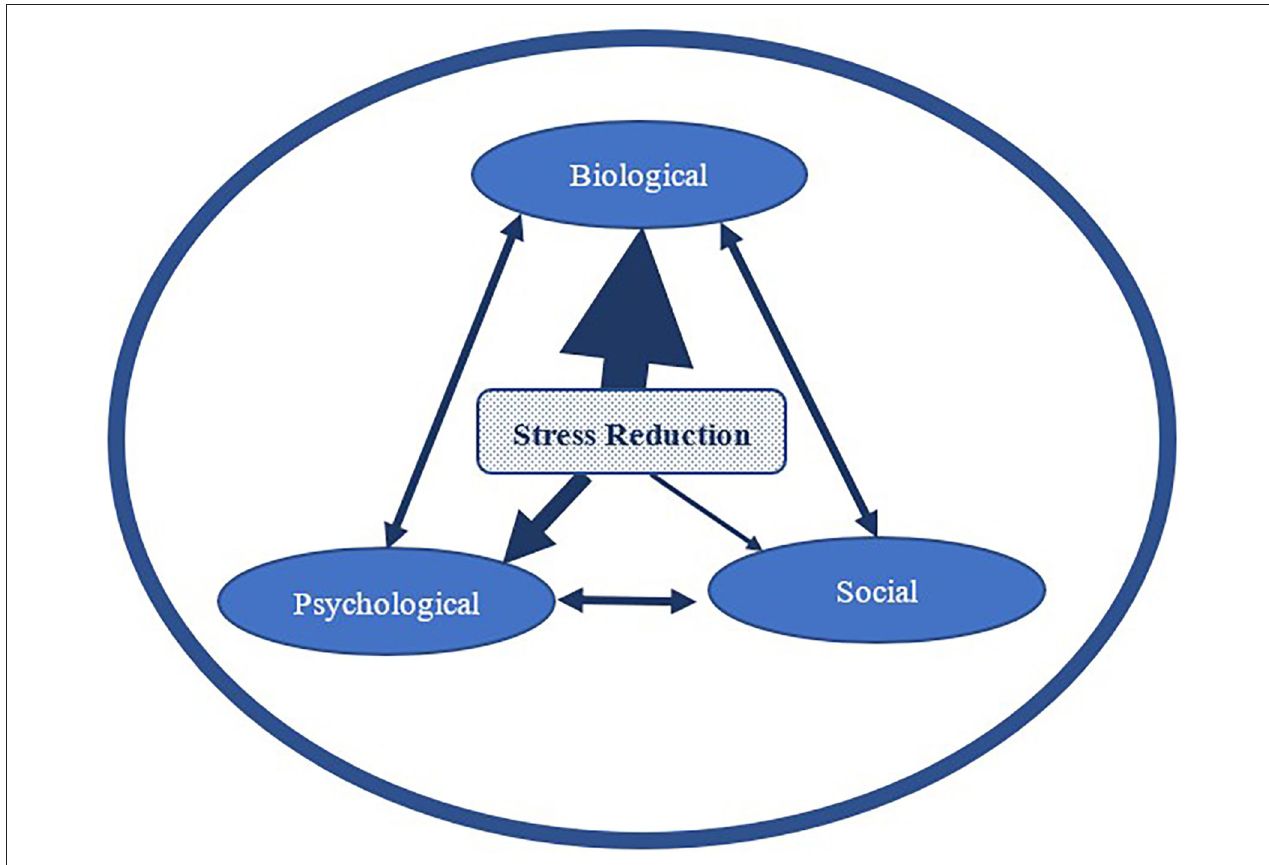
FIGURE 2 | An example of the potential for differential impact (represented by the different arrow thickness) of one mechanism of action (stress reduction) on the three realms of influence of overall health and well-being (depicted by the larger encompassing